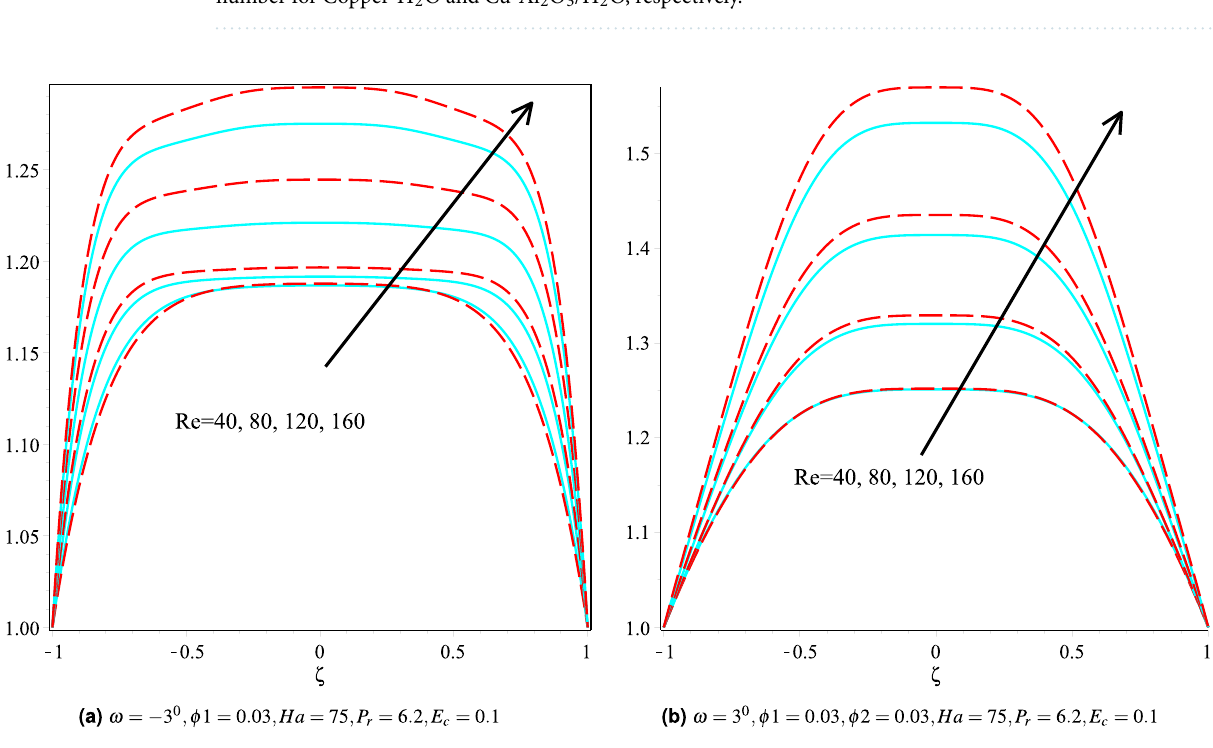
Figure 6. The heat boundary layers distribution in converging and diverging channel with particular Re for Cu/ H 2 O and Cu-Al 2 O 3 /H 2